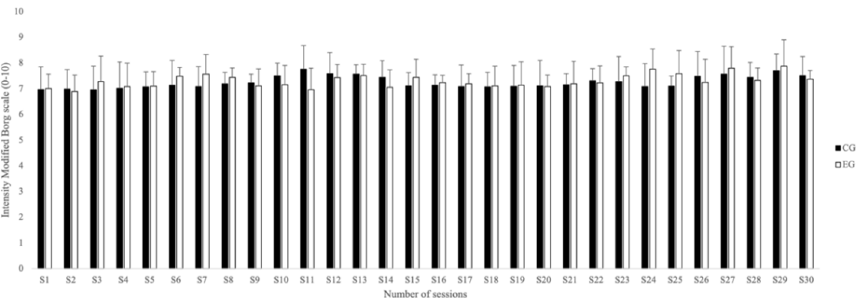
Figure 3. Average intensity (mean and standard deviation) using the modified Borg scale over the thirty training sessions. EG: experimental group; CG: control group.